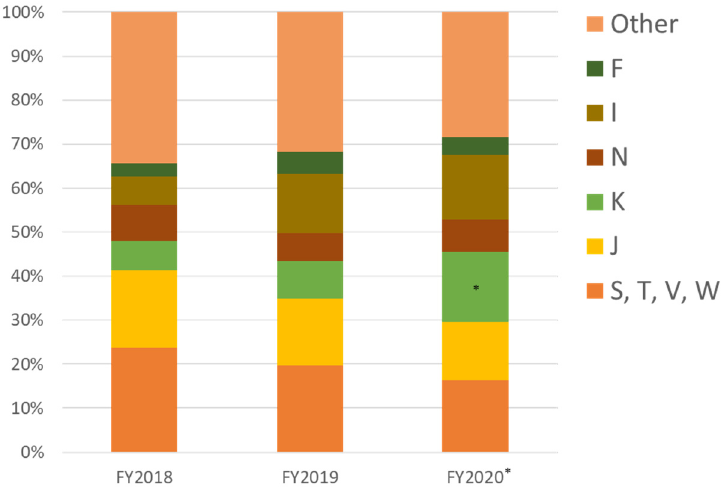
Figure 13. Proportion of inpatients treated at Futaba Medical Center by ICD classification, FY2018– FY2020. * p = 0.003 vs. 2018. The proportion of K increased compared with FY 2018. ICD: International Classification of Diseases. (F: mental and behavioral disorders; I: diseases of the circulatory system; N: diseases of the genitourinary system; K: diseases of the digestive system; J: diseases of the respiratory system; S, T: injury, poisoning, and certain other consequences of external causes; and V, W: external causes of morbidity and mortality).